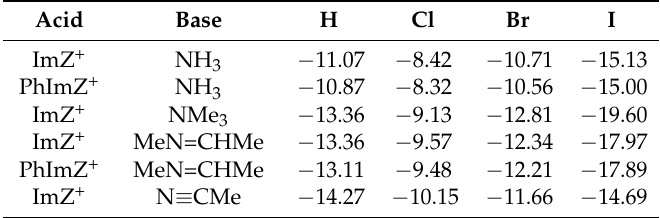
Table 2. Binding energies (kcal/mol) of substituted imidazoliums with N-bases in